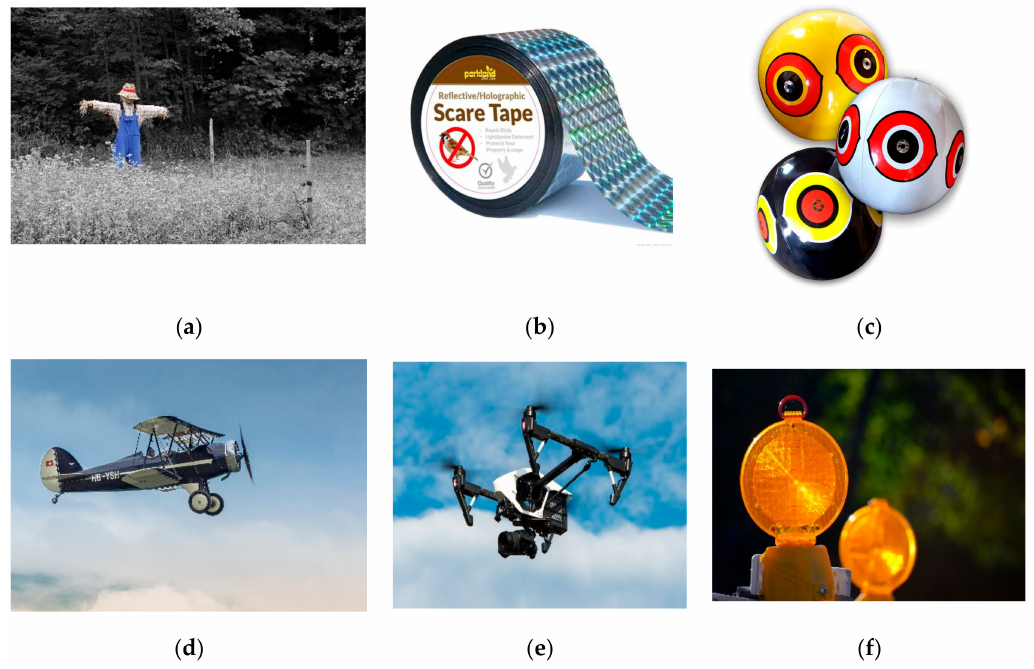
Figure 1. Visual deterrents: ( a ) scarecrows; ( b ) reflecting tape; ( c ) hawk balloons; ( d ) aircraft; ( e ) RC aircraft; ( f )